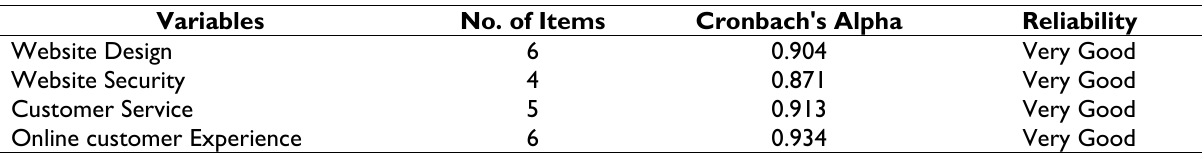
Table 3: Reliability Analysis Variables No. of Items Website Design Customer